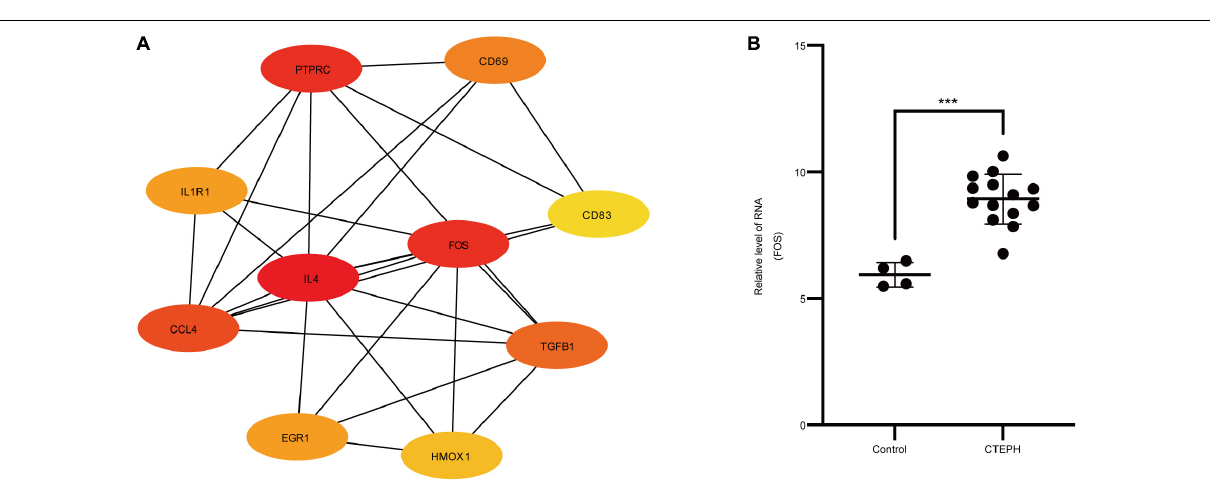
FIGURE 4 | PPI network and hub genes. (A) PPI network analyzed by the STRING database. Hub genes included IL4, FOS, PTPRC, CCL4, TGFB1, CD69, EGR1, IL1R1, CD83, and HMOX1. (B) The RNA level of FOS in the GSE130391 dataset between control group ( n = 4) and CTEPH group ( n = 14). Results are expressed as the mean ± SD, *** p < 0.001. Data were analyzed using student t